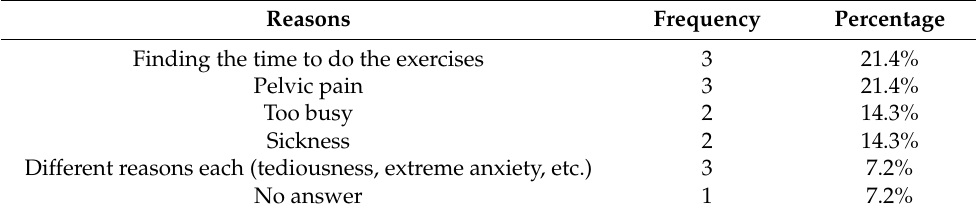
Table 2. OPALS feasibility questionnaire results on the reasons not to commit with the intervention, among those participants who completed the half or les of the intervention ( n =